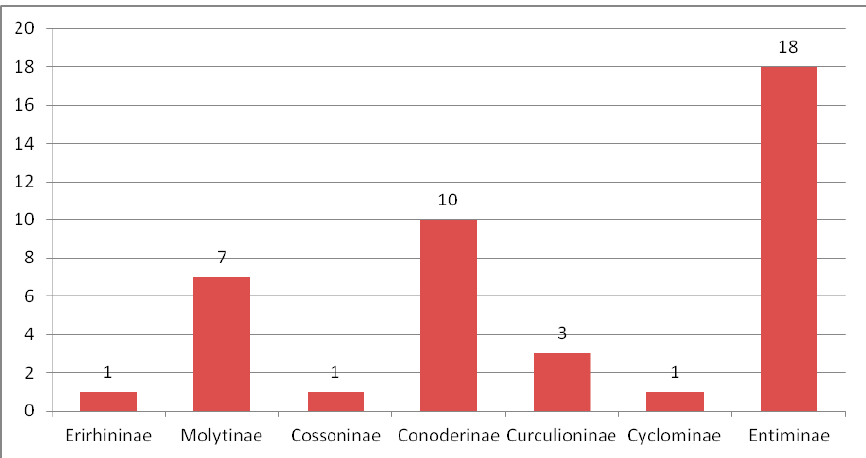
Figure 10. Composition of species of Curculionoidea in the Green River Formation.